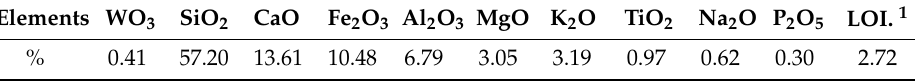
Table 1. Chemical composition of the tungsten ore from Sangdong mine in South Korea. Elements WO 3 SiO